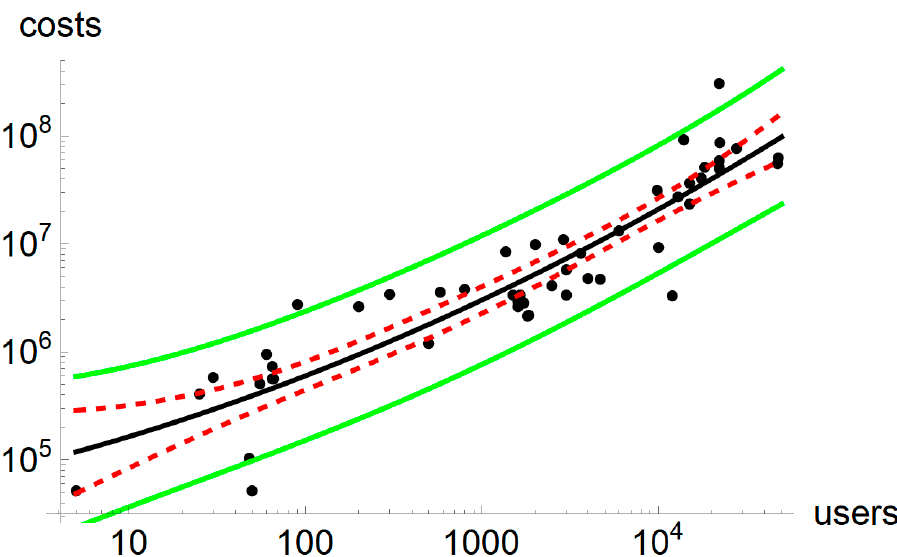
Figure 11. Capital costs (in 2015 Rupees) of decentralized sewage treatment plant (STPs) in India, based on 50 STPs across India: 47 data from [61], one pilot described in the project SARASWATI, two STPs described in this paper. The figure uses logarithmic scales (log-log-plot). The central curve comes from the regression line for the logarithm of costs as a quadratic function of the logarithm of the number of connected persons. The dotted curves come from the mean prediction band for the regression line and the outermost curves from the single prediction band. (The prediction bands for the quadratic regression functions were the one-sided 95% confidence limits for the mean of the logarithm of costs and of the logarithm of costs, respectively, of STPs of size n ). The computations and the plot used Mathematica 11.3.